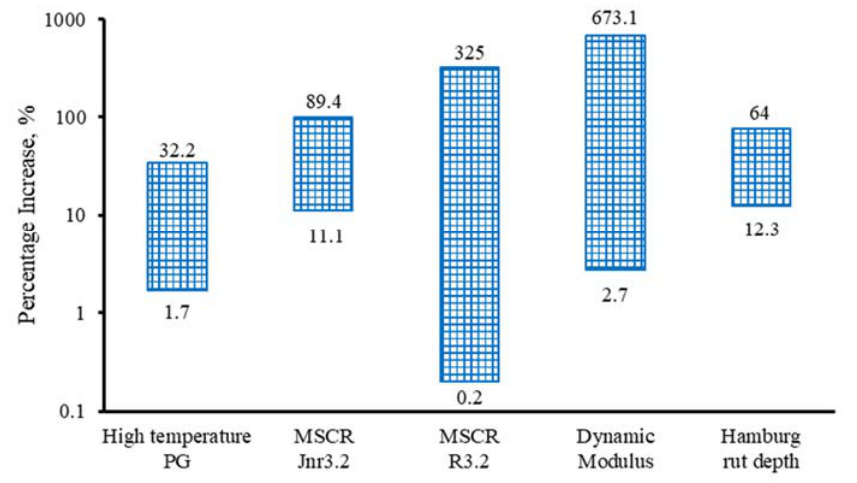
Figure 10. Percentage increase/decrease in each material